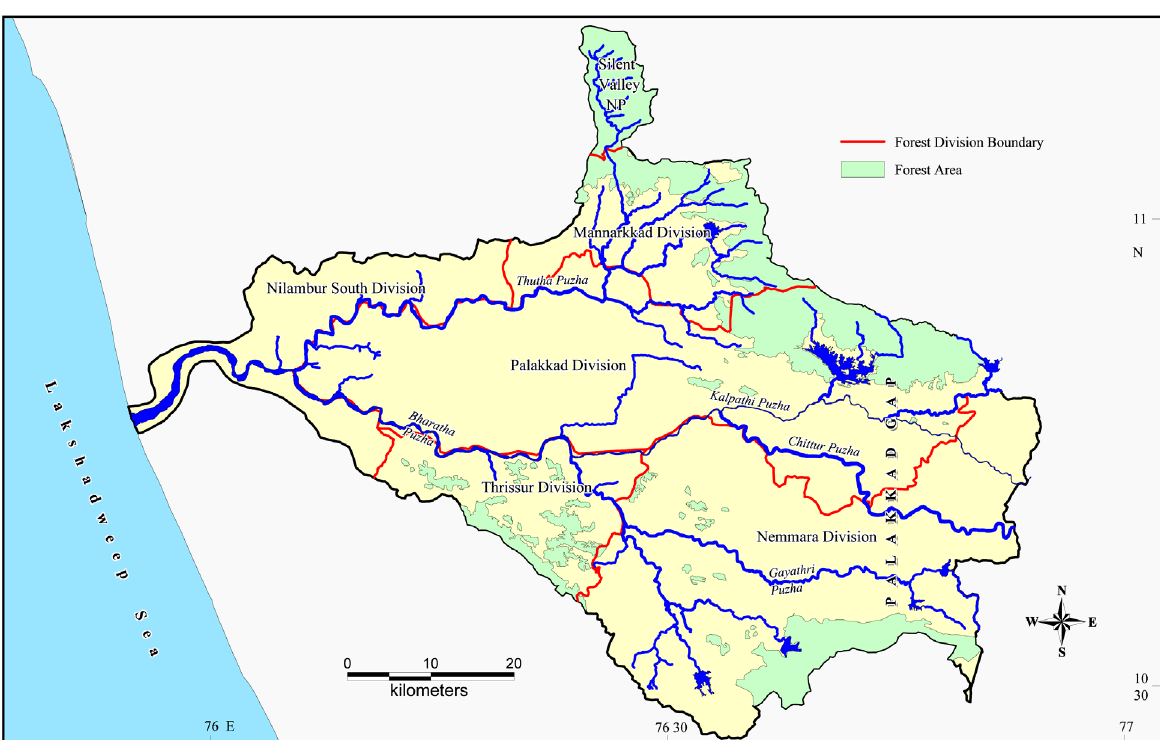
Image 2. Extent of forest cover in the Bharathapuzha River